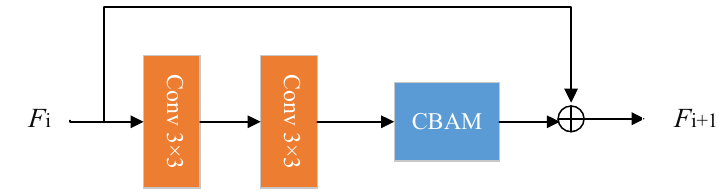
Figure 5. Convolutional attention residual block.